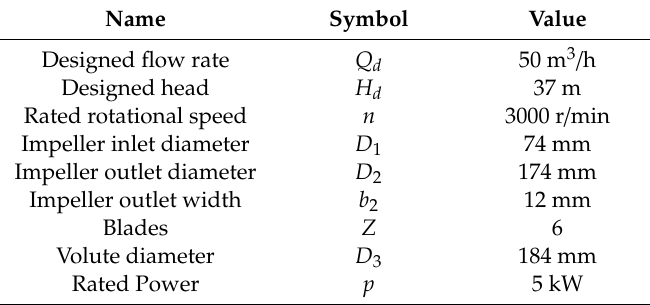
Table 1. Main parameters of the prototype pump.